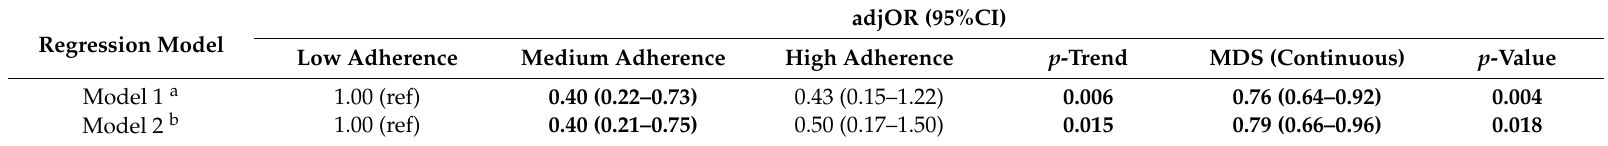
Table 5. Association between adherence to the Mediterranean diet and the risk of hrHPV